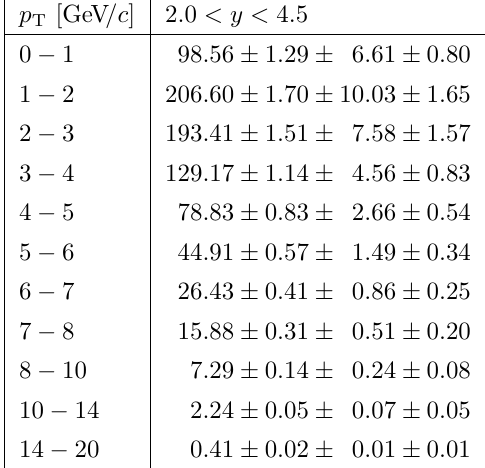
Table 5 . Single-differential production cross-sections d σ [nb/(GeV/ c )] for nonprompt J/ψ mesons in d p T the rapidity range 2 − 4 . 5 . The first uncertainties are statistical, the second are correlated systematic uncertainties shared between intervals, and the last are uncorrelated systematic uncertainties.